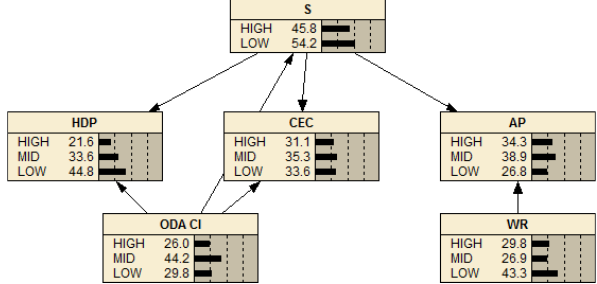
Fig. 4. Probabilities in % for the variables involved in the HDP pil- lar, discretised in high (HIGH), medium (MID) and low (LOW) lev-